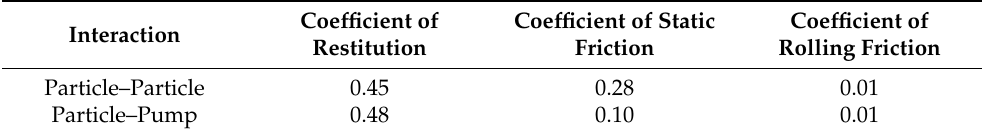
Table 3. Contact interaction settings in the